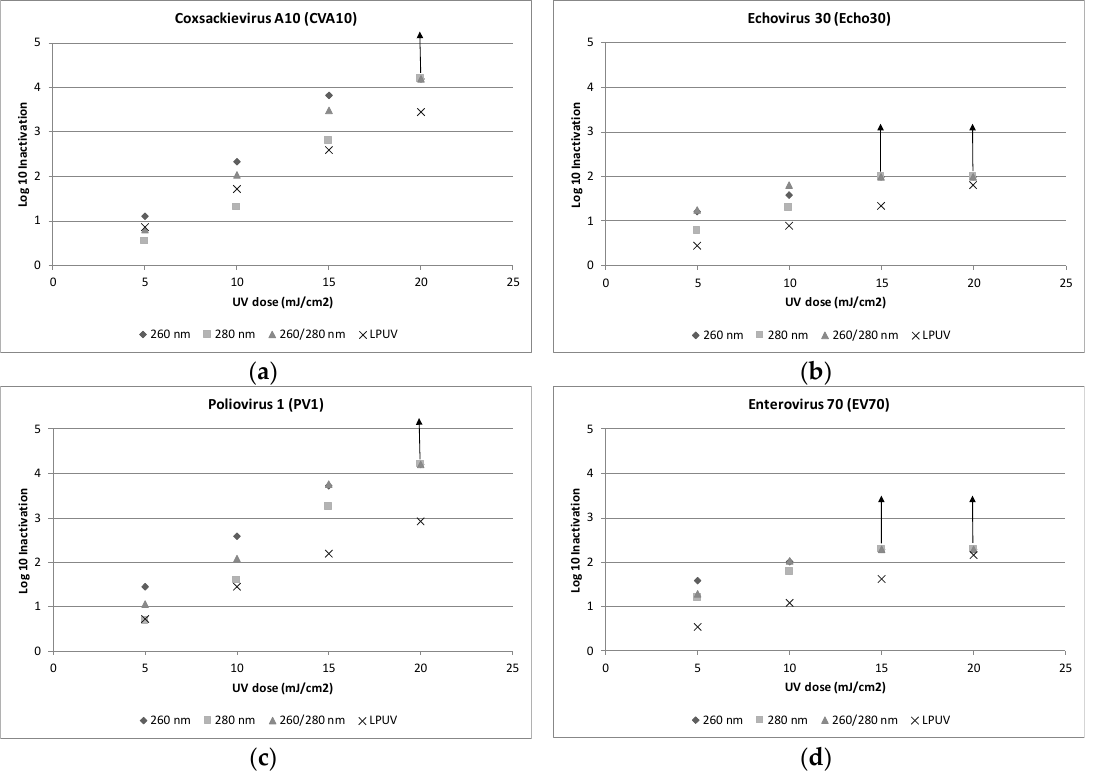
Figure 1. Log 10 inactivation of four human enteroviruses after exposure to germicidal ultraviolet light emitting diodes (UV-C LEDs) and low-pressure UV (LPUV) at 254 nm (( a ) Coxsackievirus A10, ( b ) Echovirus 30, ( c ) Poliovirus 1, and ( d ) Enterovirus 70). Arrow ( ↑ ) represents detection limit. Each data point is an arithmetic average of log 10 inactivation from independent triplicate collimated beam (CB) tests. Refer to Figure A1 for more detailed statistics, including standard deviation. The log 10 inactivation rates LPUV at 254 nm were adapted from Ryu et al. [32].